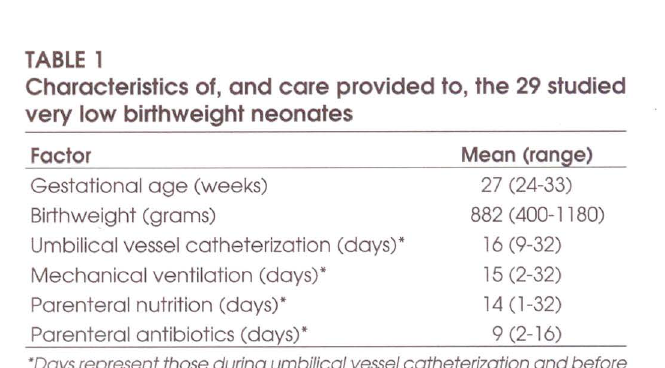
Characteristics of, and care provided to, the 29 studied very low birthweight